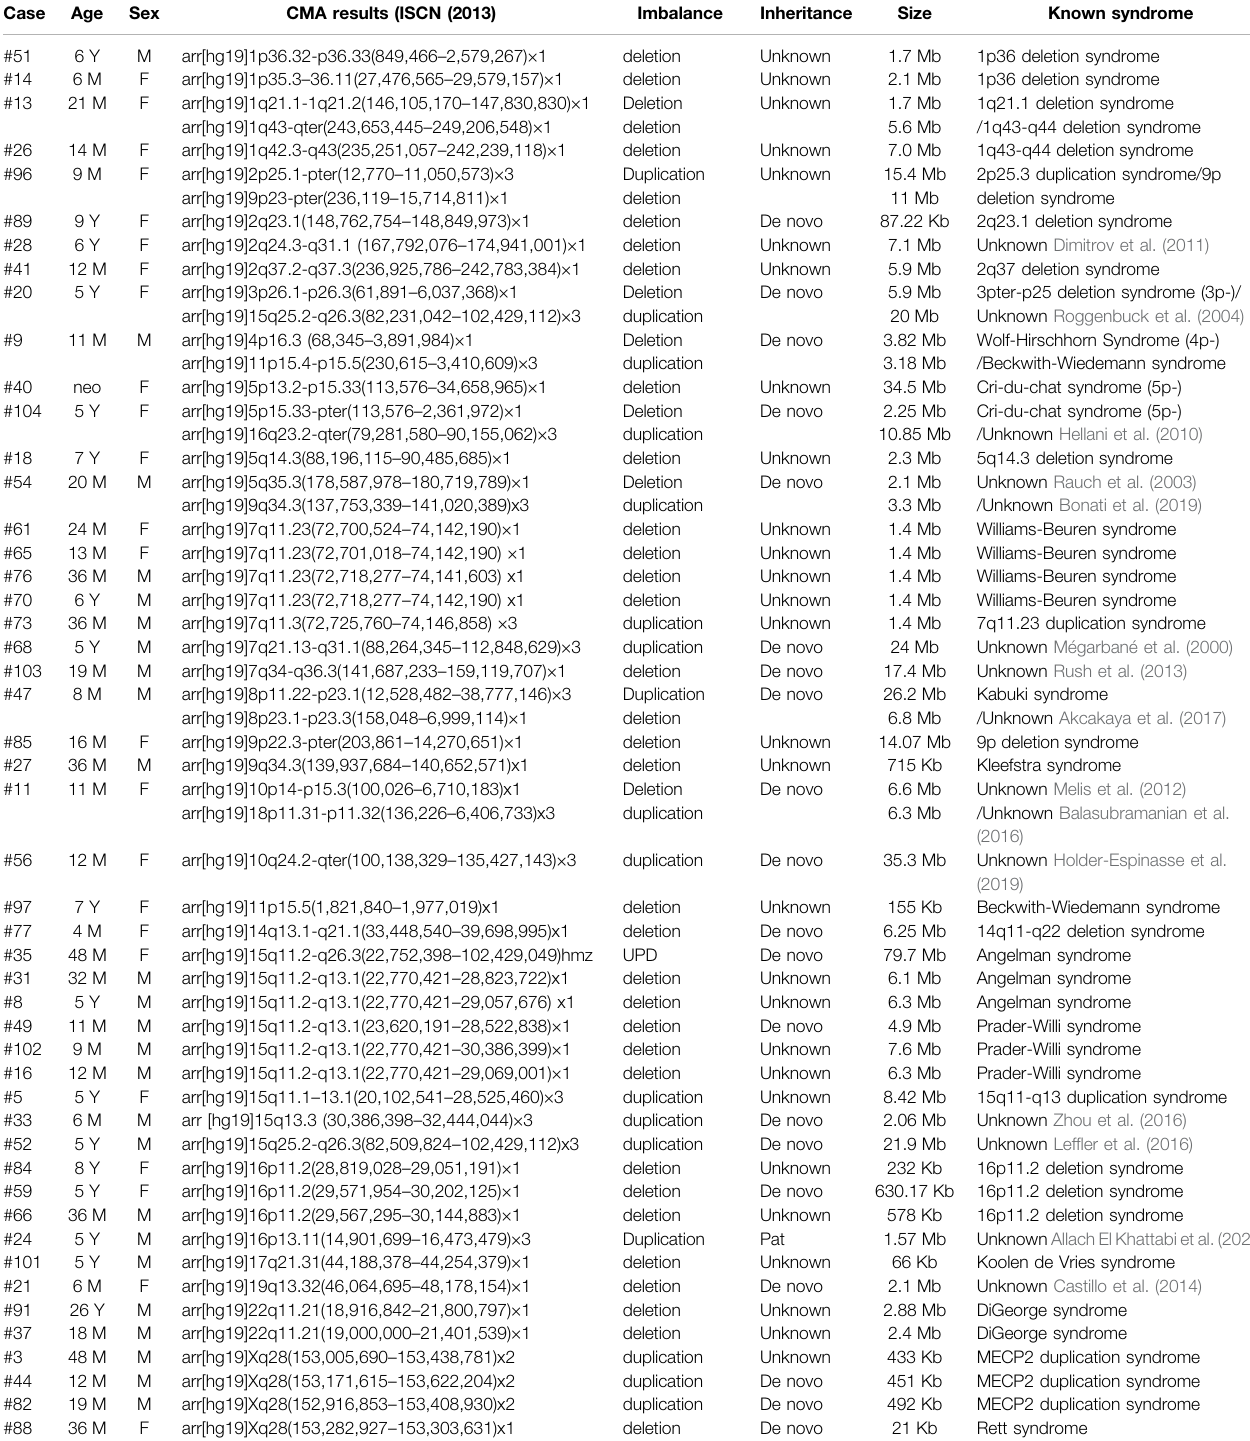
TABLE 1 | Pathogenic and likely pathogenic genomic CNVs identi fi ed by CMA in 49 patients with